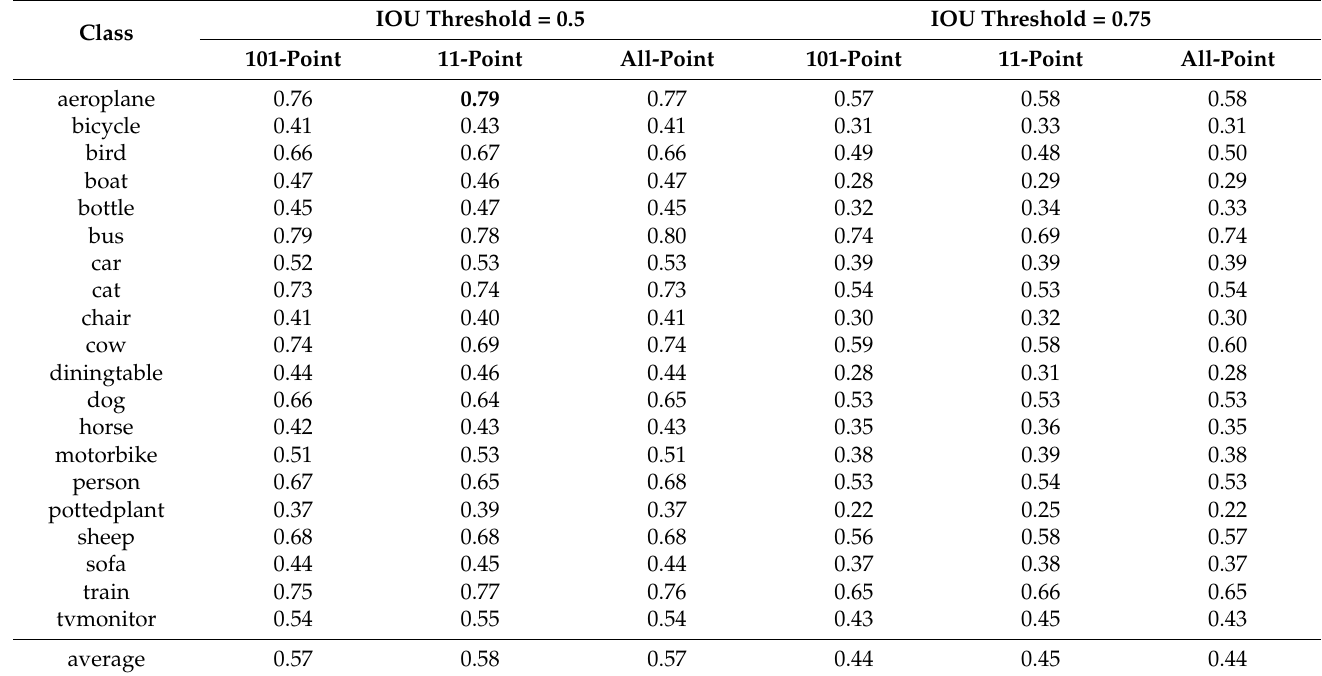
Table 5. AP results obtained with different interpolation methods and IOU thresholds.